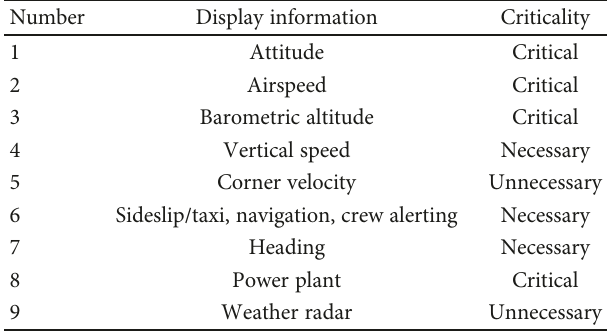
Table 2: Critical requirements for display information.